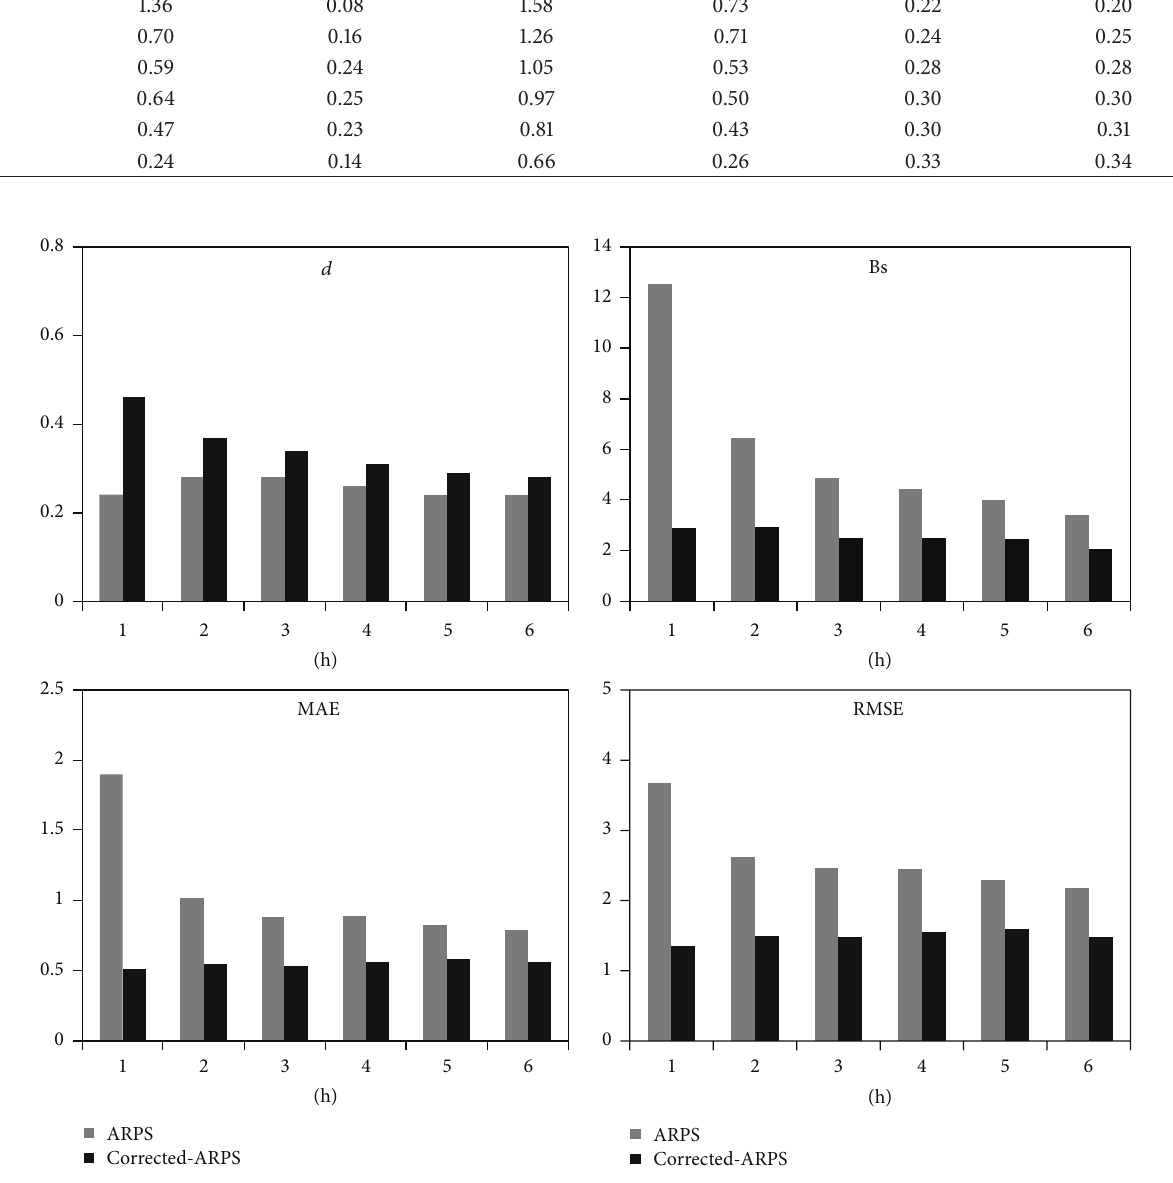
Figure 5: Average forecast performance indices over the considered three heavy precipitation events for lead times from 1h to